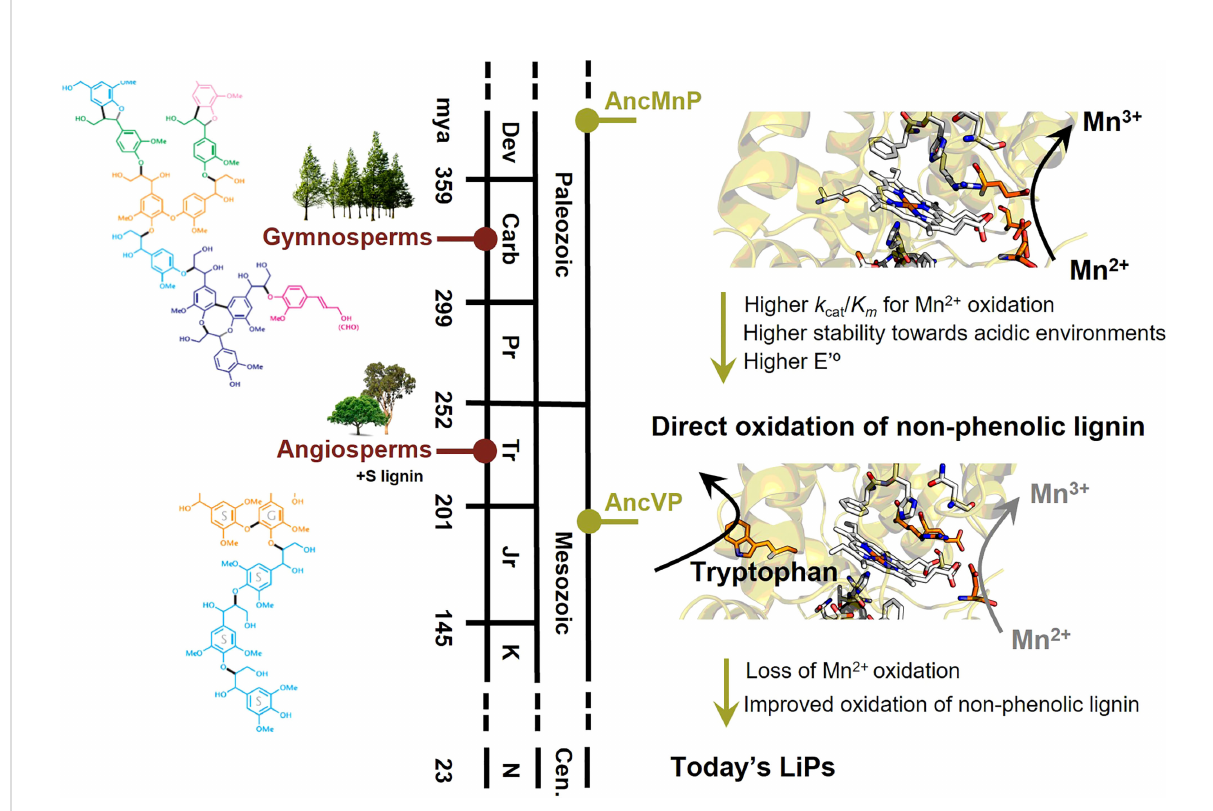
FIGURE 4 Main events in the evolution of ligninolytic peroxidases (right), in parallel with lignin evolution in gymnosperms and angiosperms (left). Initially, Mn 2+ to Mn 3+ oxidation was the main fungal strategy to oxidize lignin from gymnosperms, with only G units. This oxidation would be performed in the three acidic residues forming the Mn-binding site in ancestral MnPs (AncMnP). Once the solvent-exposed tryptophan appeared in the fi rst ancestral VPs (AncVP), the direct oxidation of the major non-phenolic moiety of lignin would be possible and improved through the evolution of peroxidases up to today ’ s LiPs. Concomitant with the change in oxidation sites, the redox potential and the stability towards acidic pHs increased. In parallel, lignin became more complex and less phenolic with the appearance of angiosperms, including S lignin in its structure, and the above changes in ligninolytic enzymes were a fungal response to this increased complexity. The time-calibration was taken from (Ayuso-Ferna ́ ndez et al., 2019b) and (Morris et al., 2018).